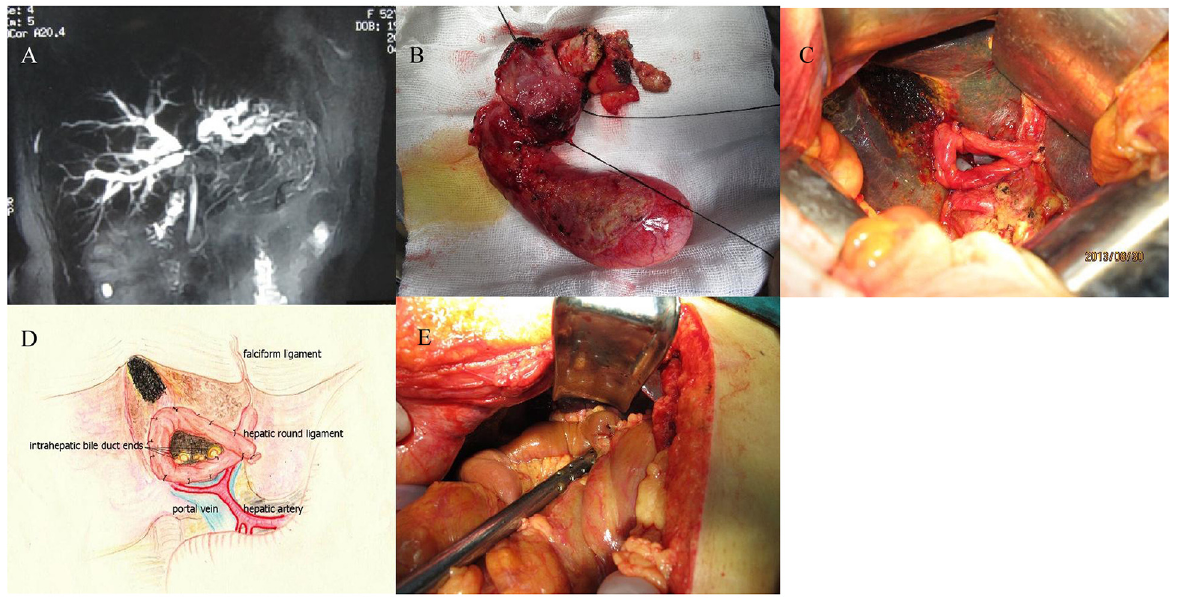
Fig 1. Preoperative imaging examination of hilar tumor and key surgical procedures. (A) Representative appearance on magnetic resonance cholangiopancreatography; (B) en bloc resection of the hilar tumor; (C) appearance of multiple intrahepatic bile duct openings on the hilar stump; (D) circumferential enhancement of the hilar stump with the AHRLF; and (E) anastomosis of the Roux-en-Y hepaticojejunostomy with the AHRLF.